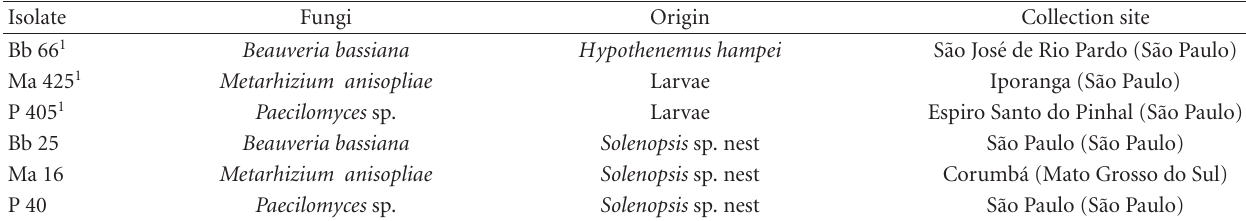
Table 2: List of tested fungi on Monomorium floricola colonies under laboratory conditions. Isolate